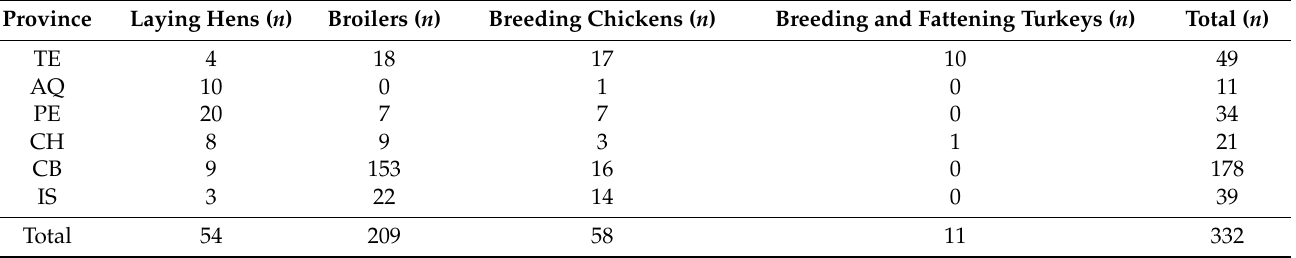
Table 1. Flocks tested in the period 2015–2020 in Abruzzo and Molise provinces, by category. Values are numbers of